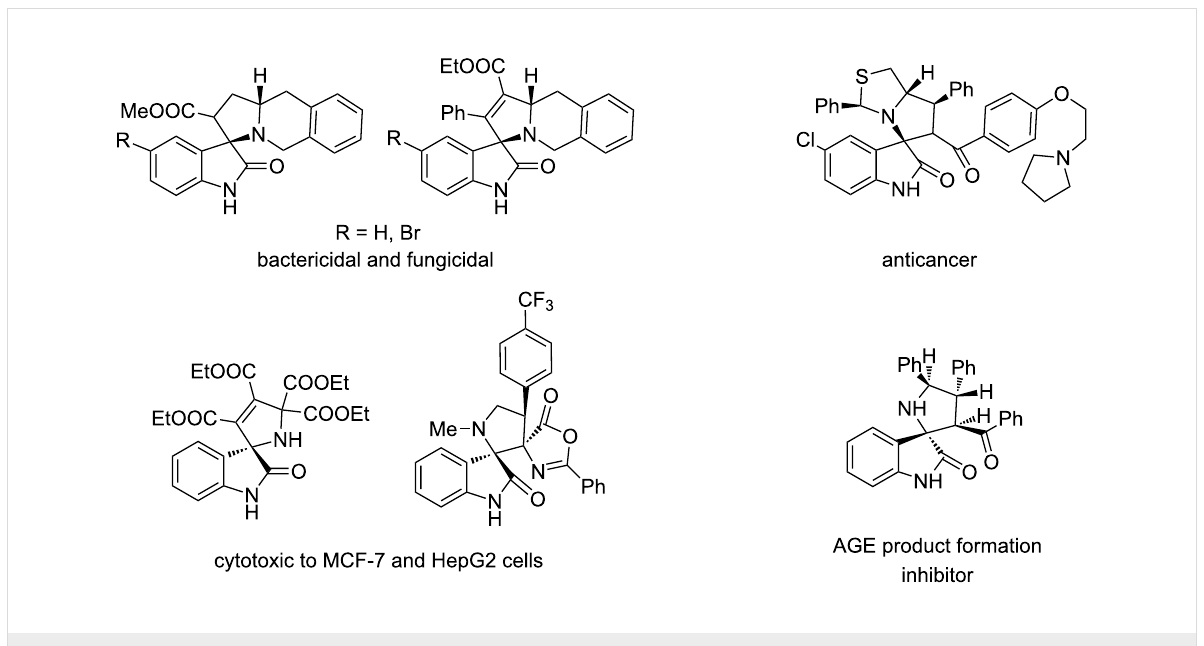
Figure 1: Bioactive